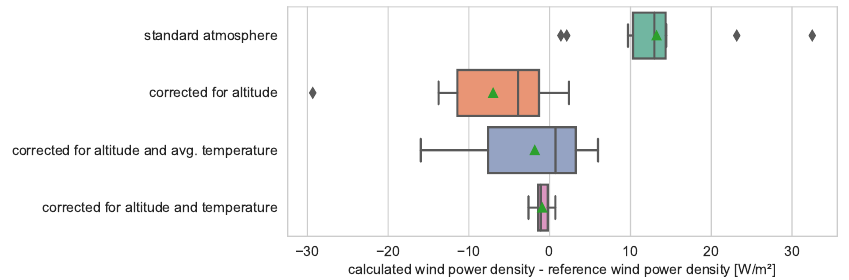
Figure 6. Monthly sensitivity of the mean wind power density to missing